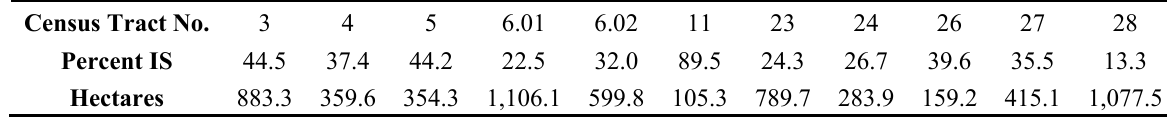
Table 2. Percent impervious (IS) delineated from aerial photos and total area of census tract. Census Tract No.